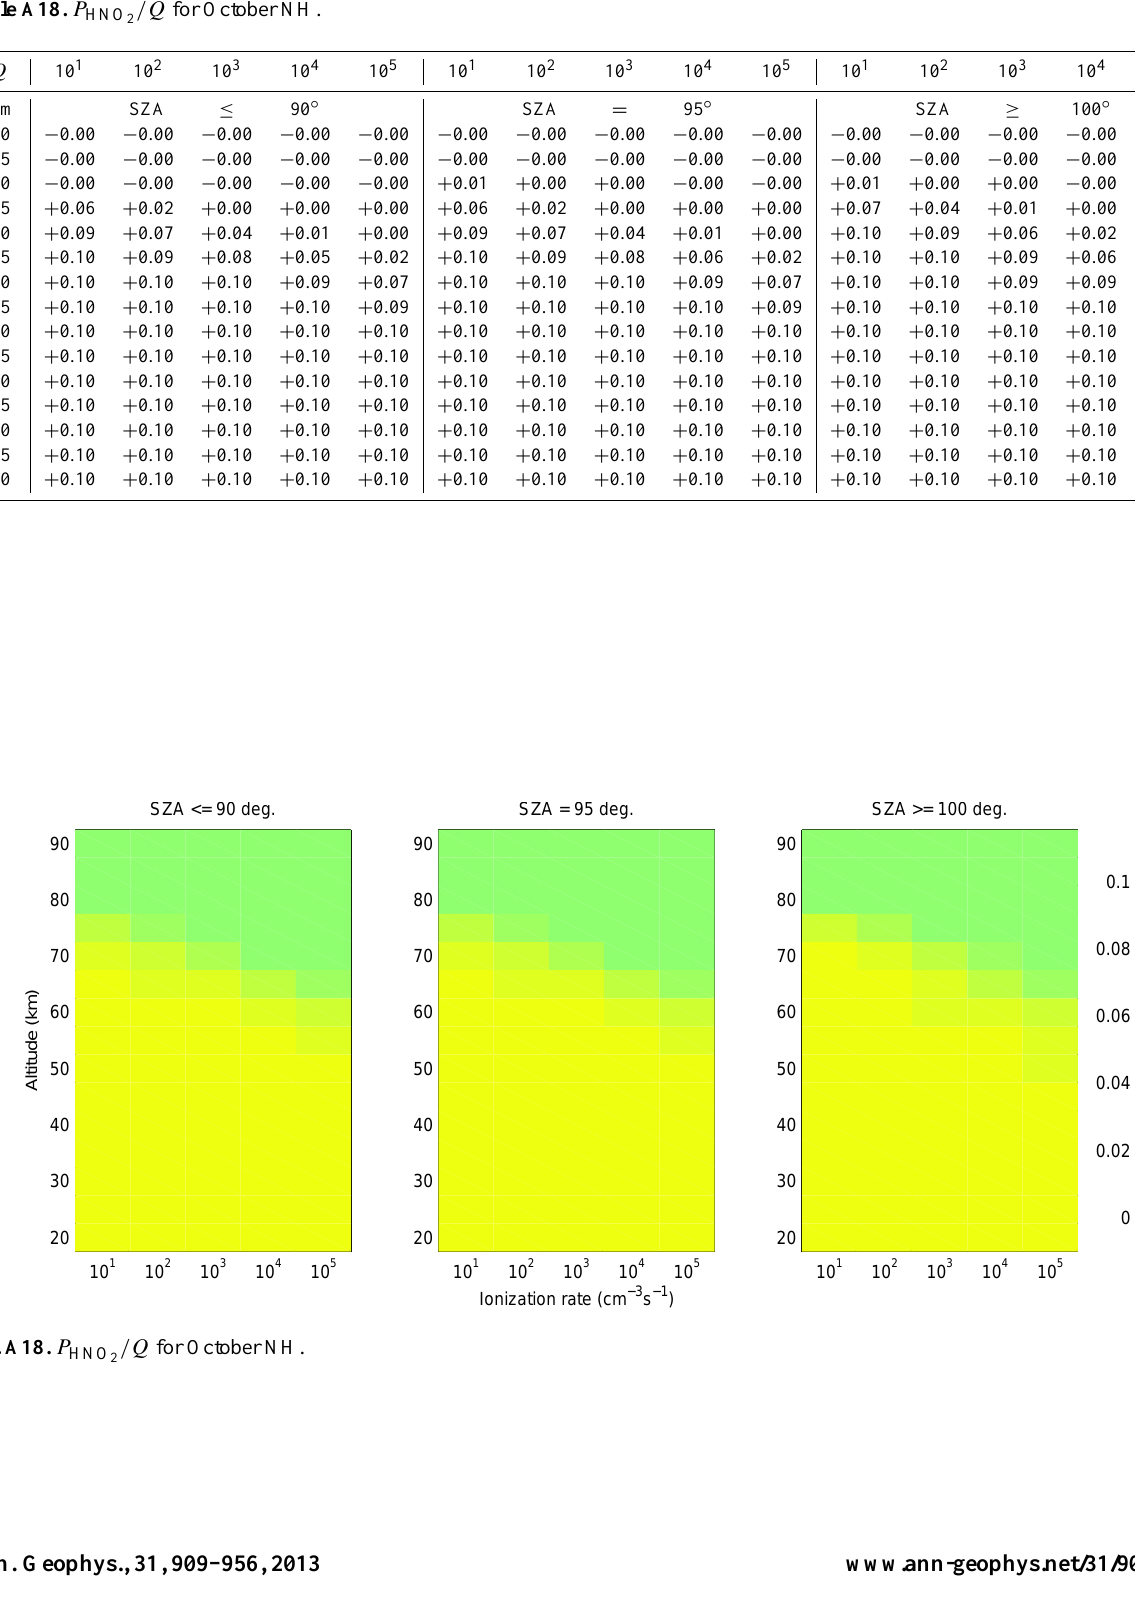
Table A18. P HNO